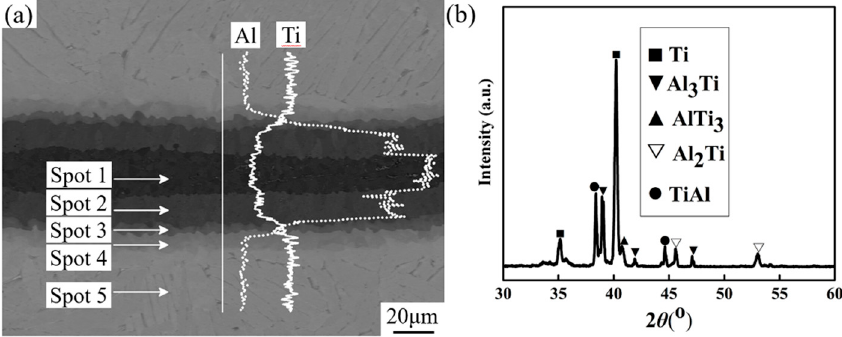
Figure 5. ( a ) Typical back-scattered electron (BSE) image of the Ti-Al reaction zone and Energy Dispersive X-ray Spectrometry (EDXS) linescan analysis results, ( b ) X-Ray Diffraction (XRD) pattern of this composite.